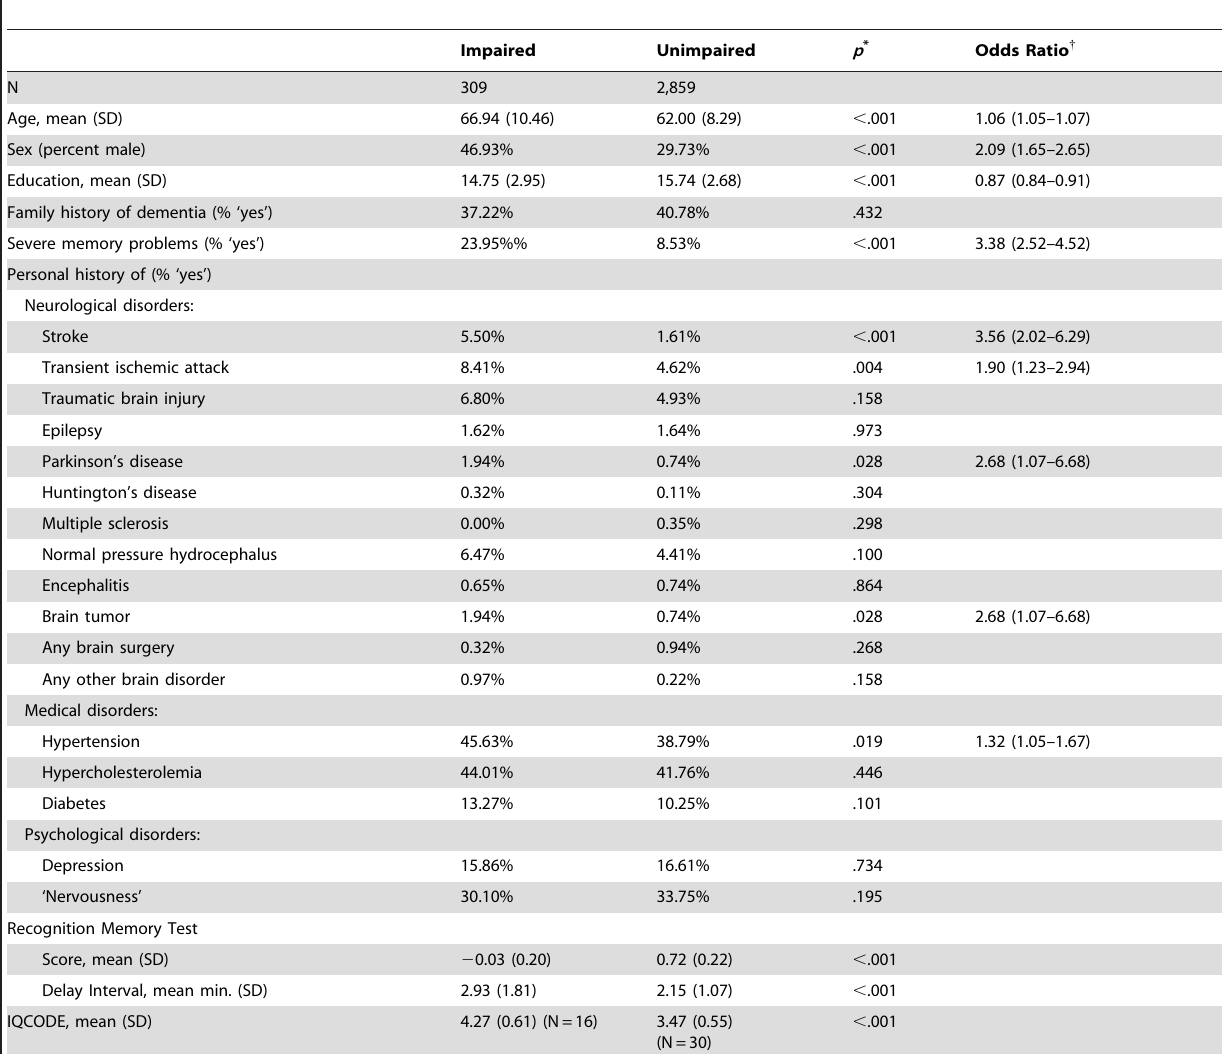
Table 1. Comparison of older respondents from the Anonymous Internet Sample who were impaired ( , 10 th percentile) or unimpaired on the recognition memory